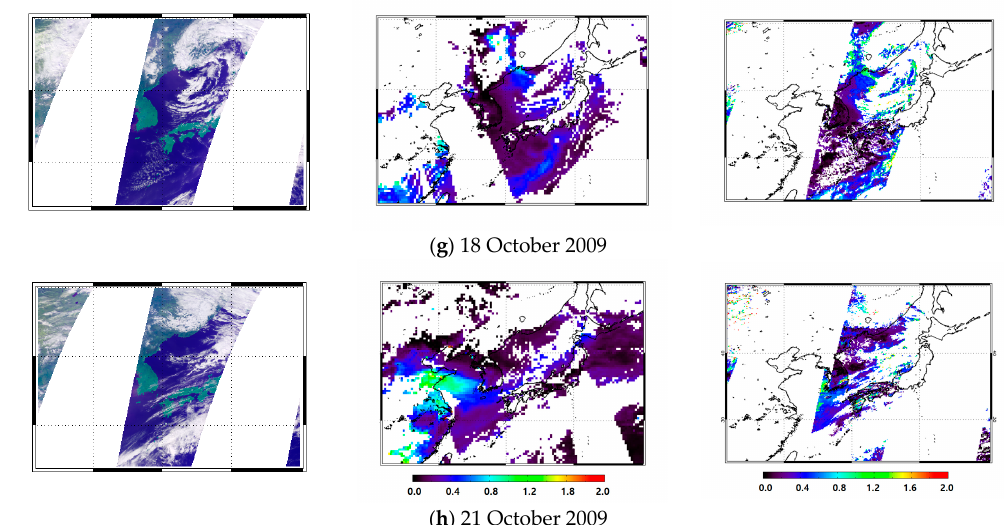
Figure 5. Examples of the (left) TANSO-CAI false color image, (middle) Aqua/MODIS DB_AOD or DT_AOD (collection 6) with 0.3° grid pixel resolution, and (right) CAI AOD with 0.1° grid pixel resolution over Northeast Asia on ( a ) 3 June; ( b ) 1 September; ( c ) 12 September; ( d ) 13 October 2009; ( e ) 15 October; ( f ) 16 October; ( g ) 18 October; and ( h ) 21 October 2009. Black color represents 0.0 of AOD and red color means 2.0 of AOD.